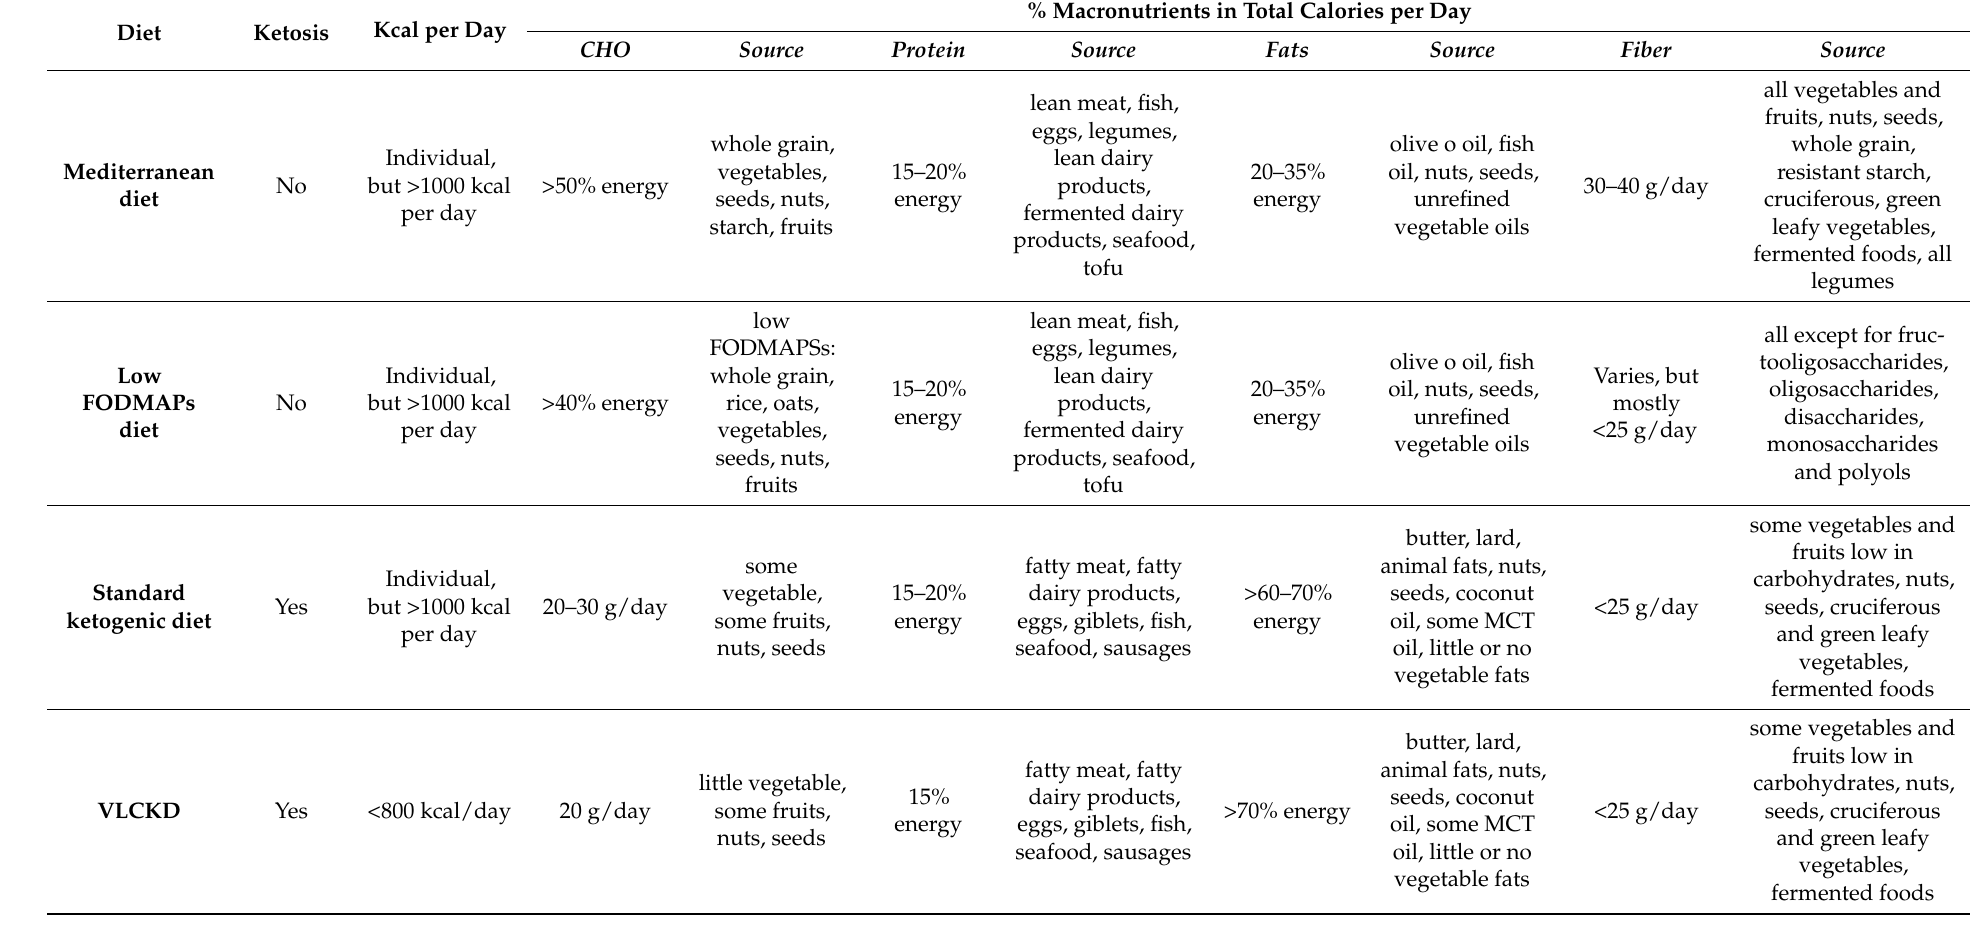
Table 3. Characteristics of different types of